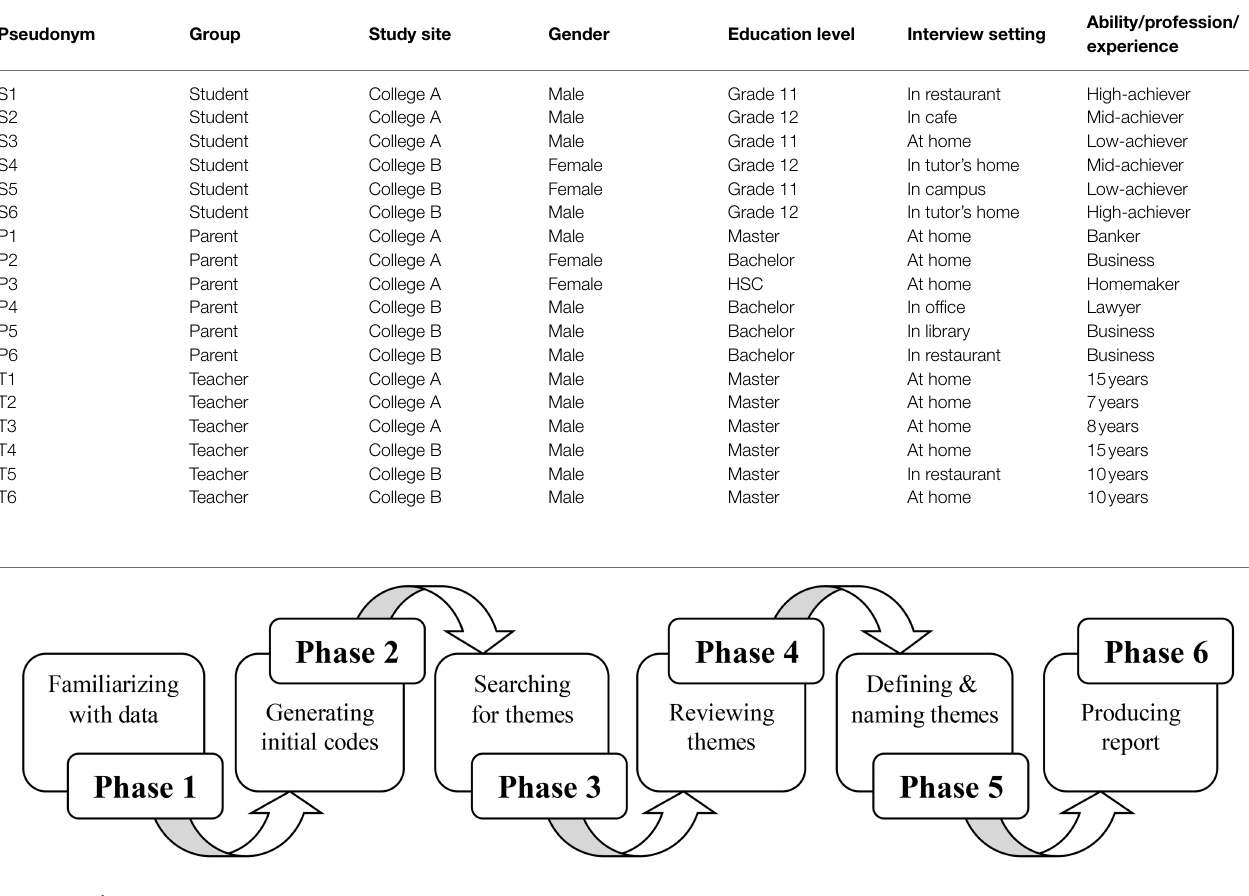
FIGURE 2 | Six-step thematic analysis procedure. Source: Braun and Clarke